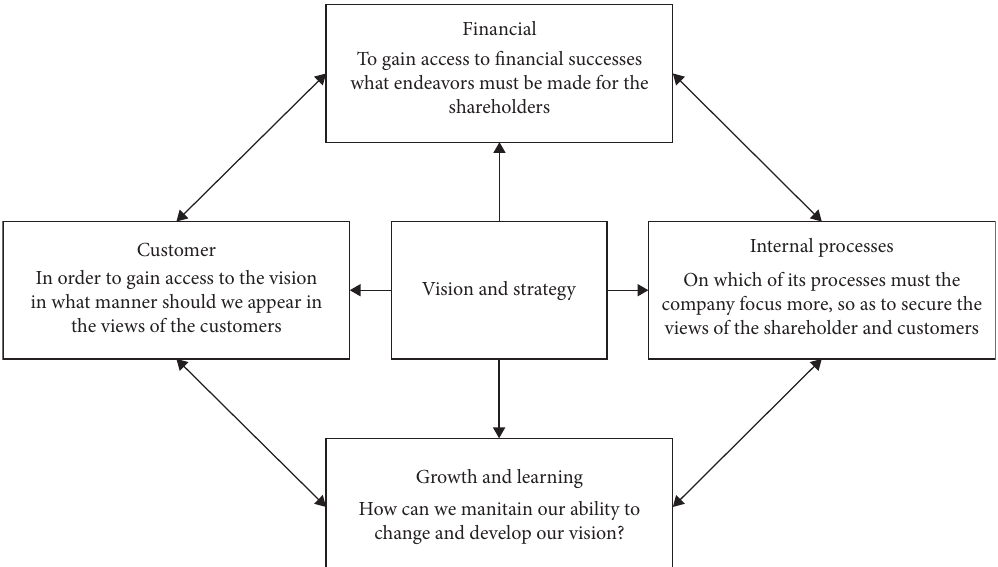
Figure 1: Transforming the vision and strategy into the four BSC aspects.